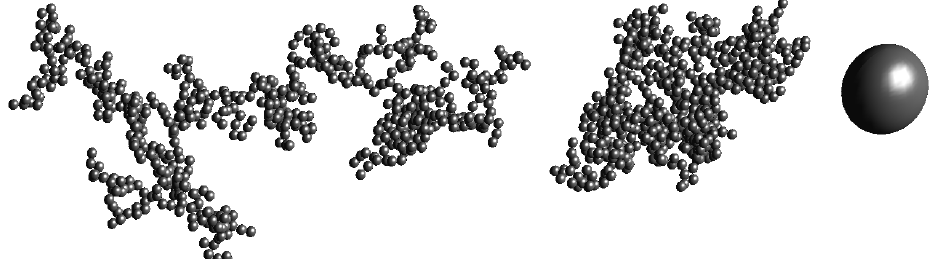
Fig. 1. Examples of model particles considered in this study: Lacy aggregates (left, D f = 1 . 8, k 0 = 1 . 3), compact aggregates (centre, D f = 2 . 4, k 0 = 0 . 7), volume-equivalent, homogeneous spheres (right).